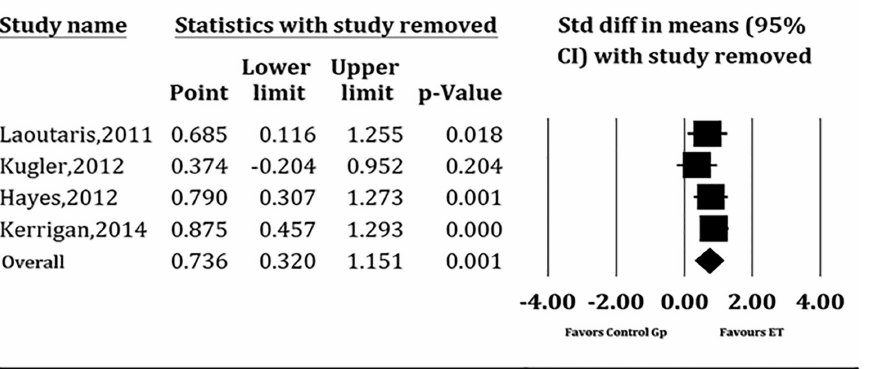
Fig 3. Forest plot depicting sensitivity analysis of studies pooled to analyze effect of supervised exercisetraining on exercisecapacity measuredas peak oxygen uptake (ml/kg per min). ET = exercise training, Gp =